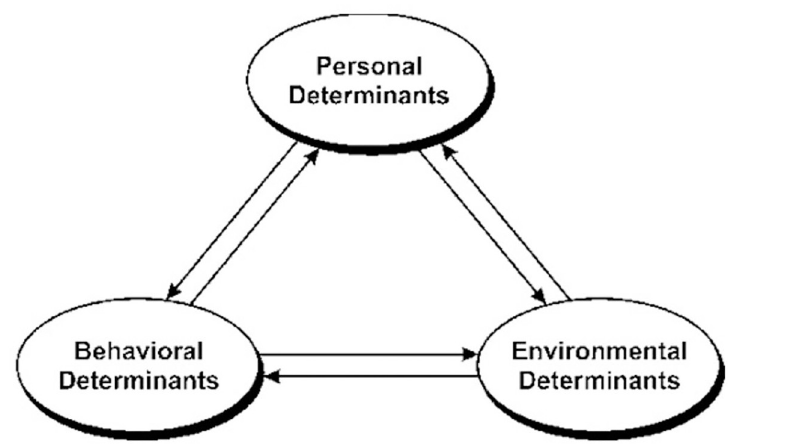
Fig 1. Social cognitive theory basic